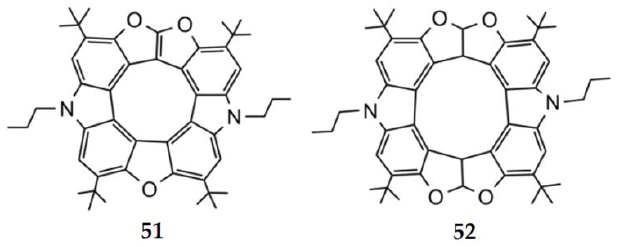
Figure 17. Molecular structures of the studied heterocyclic [9]- and [10]circulenes. According to the ACID plots of [9]circulene 51 , the diatropic ring currents appear in the outer rim (blue arrows in Figure 18), while the 9-membered hub ring sustains paratropic currents (red arrows in Figure 18) similar to those of the hetero[8]circulenes presented